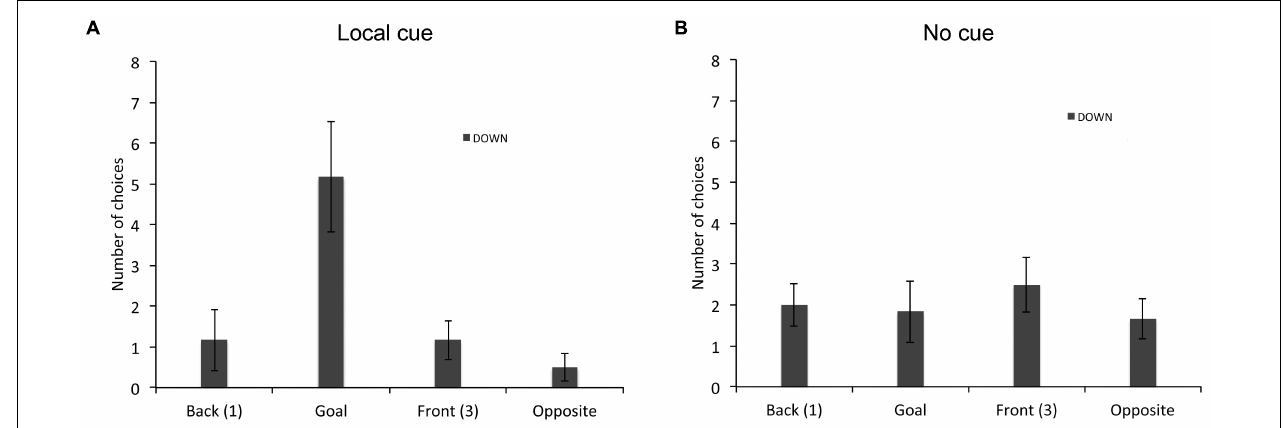
FIGURE 4 | Proportion of choices (goal location (2), opposite location (4), back location (1), or front location (3), as the first choice upon entering the arena; mean + / − SEM) made by individuals with DS, who did not perform above chance level the place learning task, in presence (A) or absence (B) of a local cue marking the reward